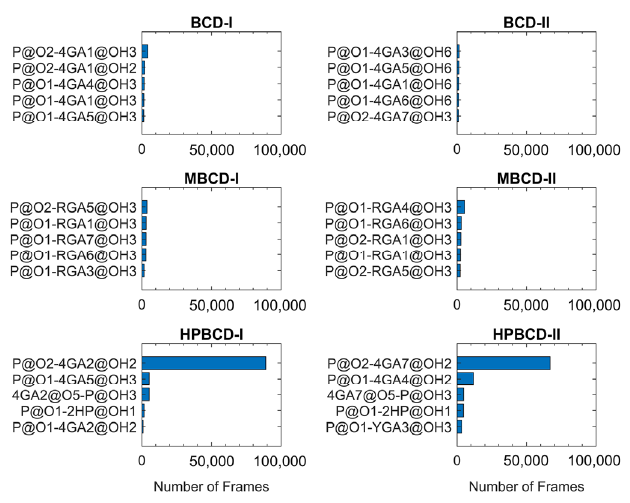
Figure 6. The hydrogen bonding frequency plot of all inclusion complexes with the highest five ranks is shown as blue horizontal bars. Y-axis labels indicate the interacting atom pairs and x-axis labels indicate the number of frames that the hydrogen bonding occurred between each pair. The plumbagin molecule is denoted by P. The hydroxypropyl group is denoted by 2HP. The glucose units are denoted by 4GA, RGA, or YGA. Please note that the number after glucose unit notation refers to the numeric order of glucose units in BCDs. The one and two letter abbreviations of the atom and functional group name, followed by its position in the numeric form, are specified after @ symbol.